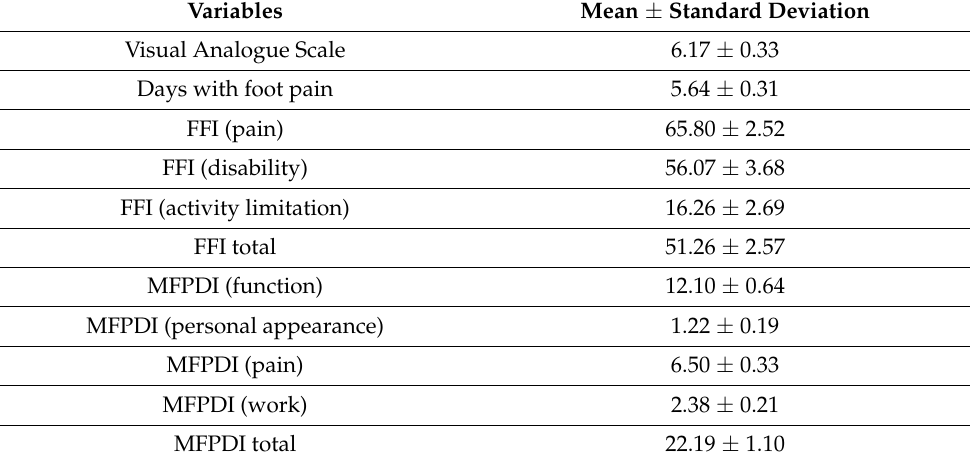
Table 2. Pain and foot disability